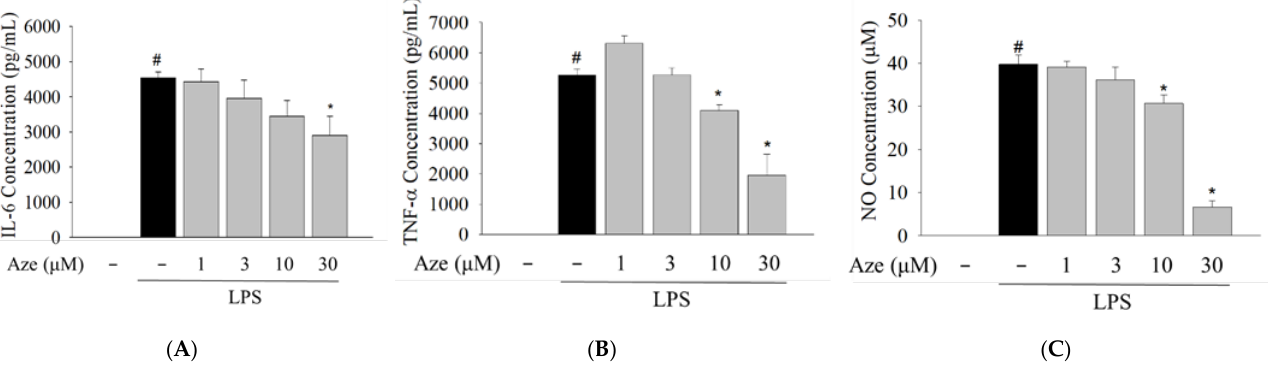
Figure 4. Aze suppressed the LPS-stimulated production of pro-inflammatory molecules in BV2 cells. Cells were treated with LPS (1 µ g/mL) and the indicated concentrations of Aze. Control cells were treated with vehicle only. Culture media were collected after 24 h of treatment, and the levels of IL-6 ( A ), TNF- α ( B ), and NO ( C ) were determined as described in the Materials and methods. Data are presented as the mean ± SEM from three independent experiments. # p < 0.05 and * p < 0.05 vs. vehicle-treated control and LPS-treated cells,